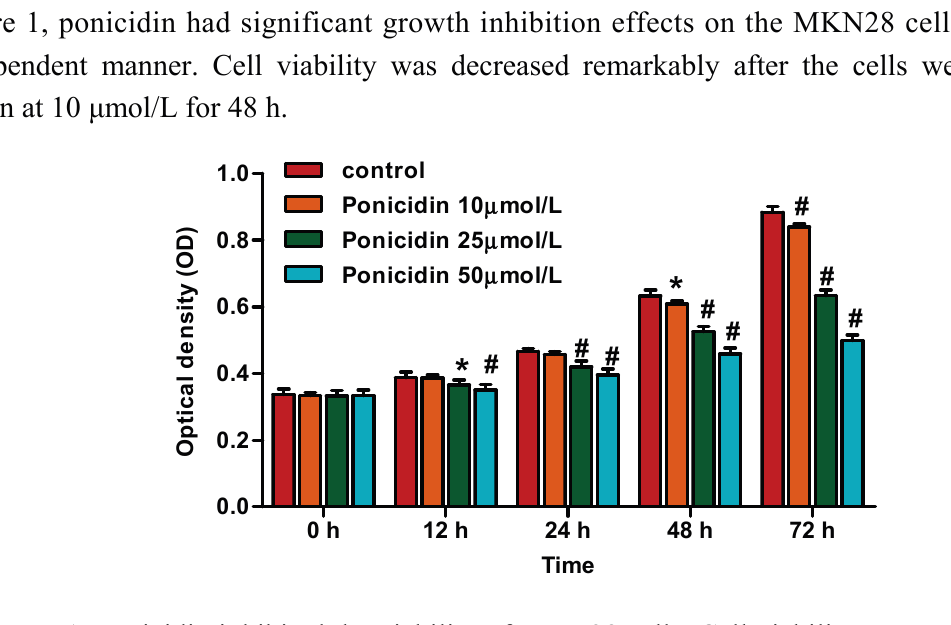
Figure 1. Ponicidin inhibited the viability of MKN28 cells. Cell viability was measured by the Cell Count Kit-8 (CCK8). Ponicidin (10, 25 and 50 μ mol/L) significantly inhibited MKN28 cells viability in a time- and dose-dependent manner when compared with the control group. Date are presented as mean ± SD (standard deviation) ( n = 3). * p < 0.05, # p <